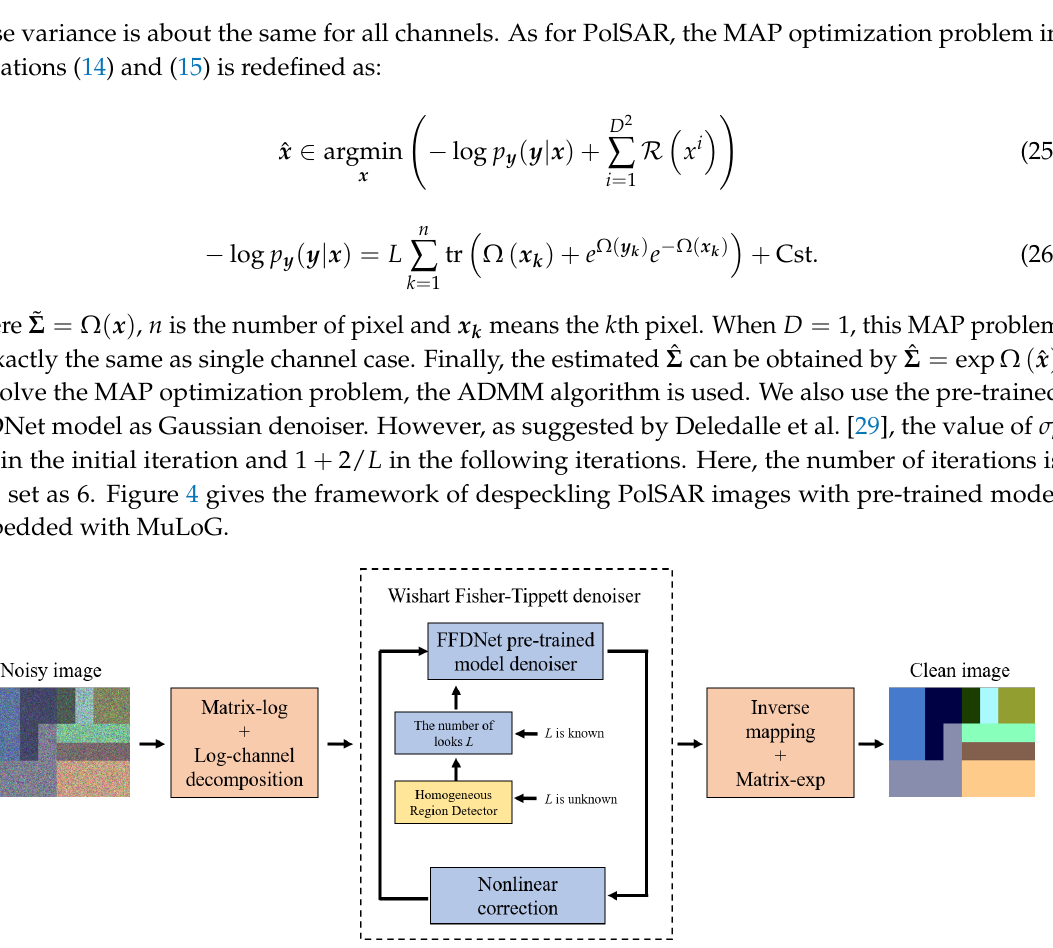
Figure 4. The framework of MuLoG-FFDNet filter for PolSAR